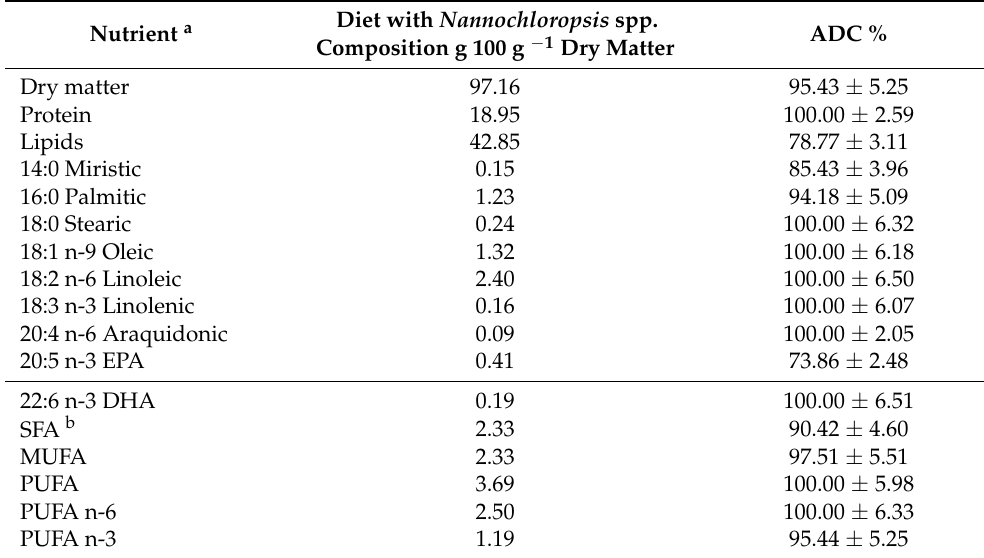
Table 4. Diet composition and apparent digestibility coefficient (ADC) of Nannochloropsis spp. meal for the Pacific white shrimp.